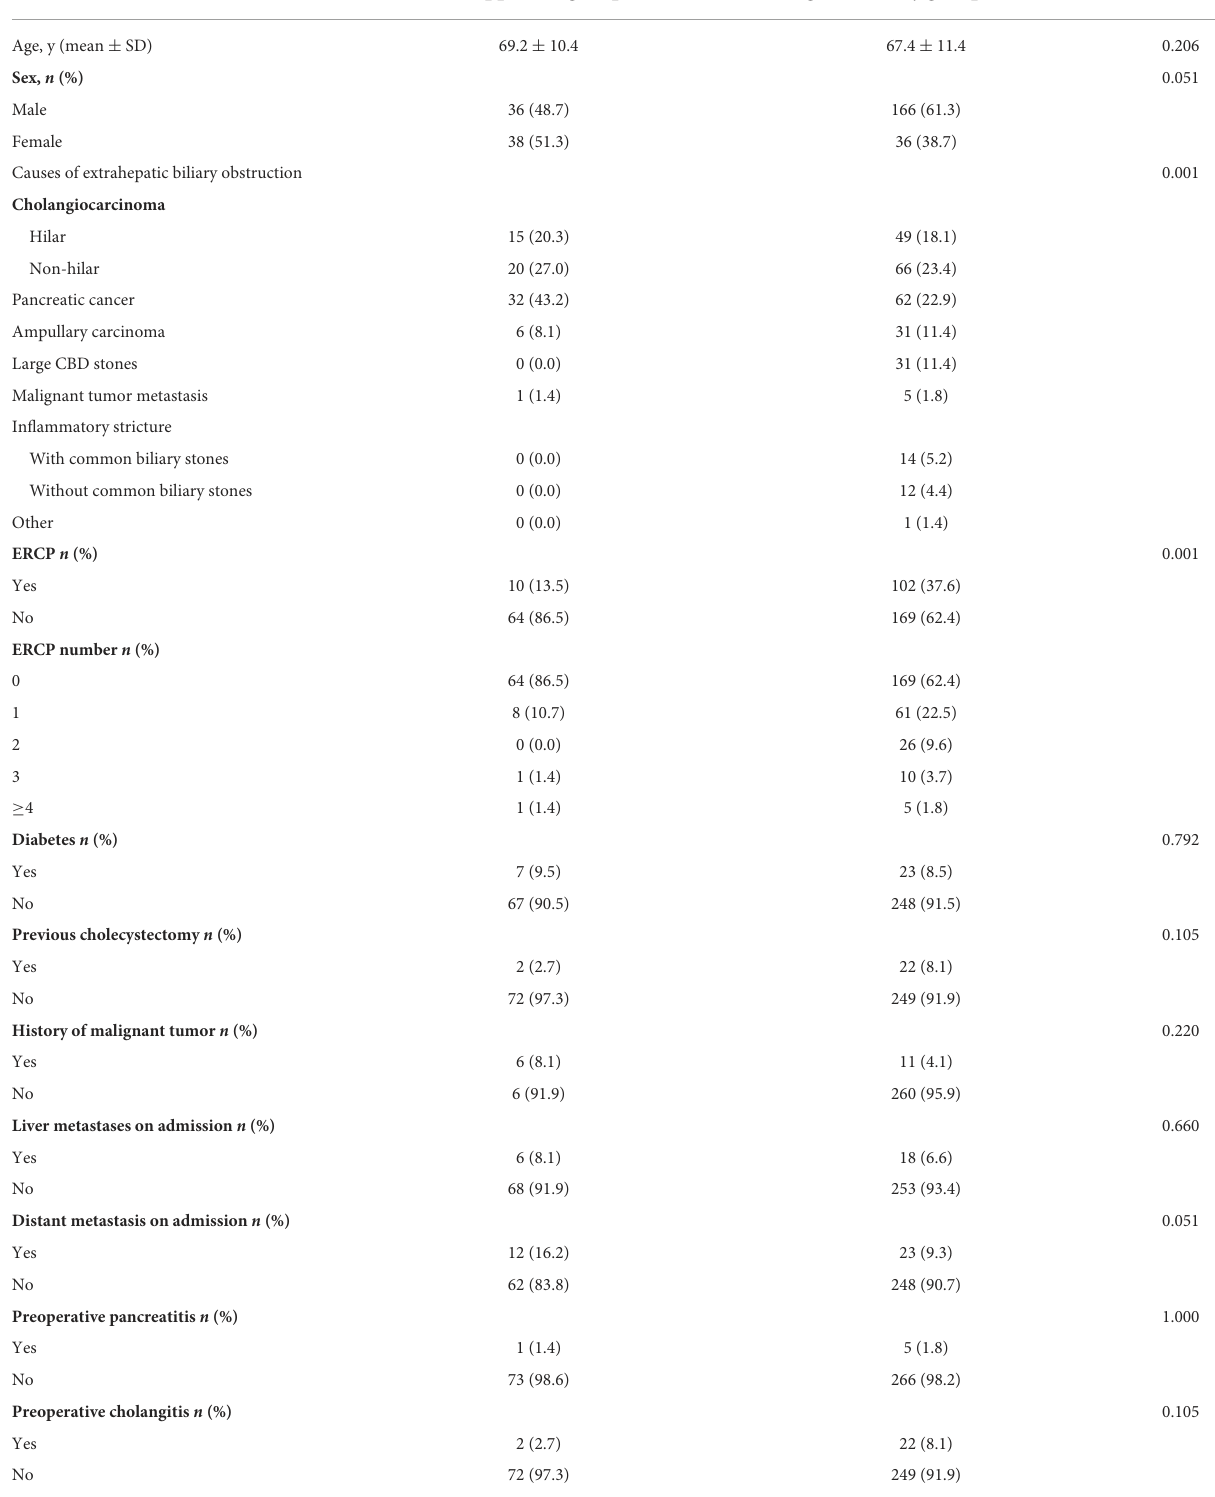
TABLE 2 Clinical characteristics of the two